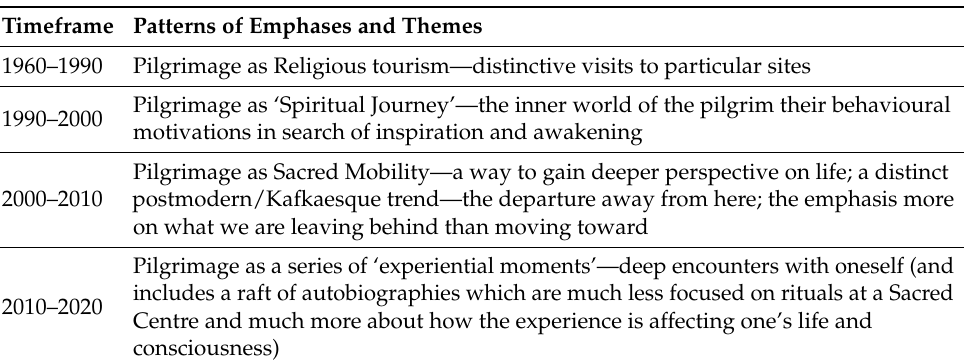
Table 1. An Inventory of themes in contemporary personal accounts of pilgrimage (After Flanagan